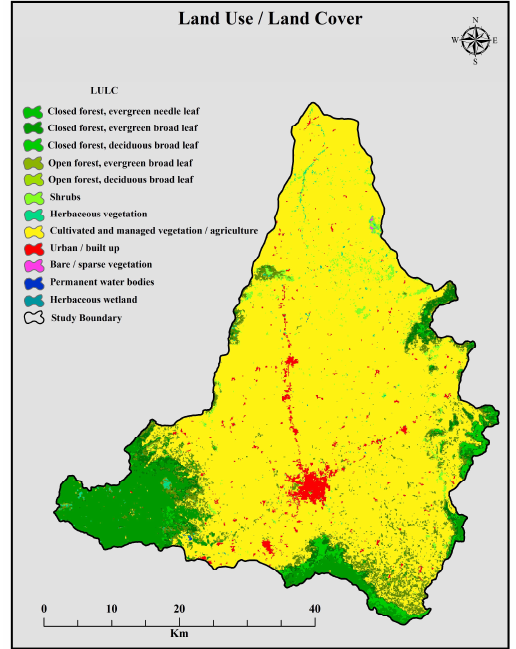
Figure 2: Landuse/Landcover of Study